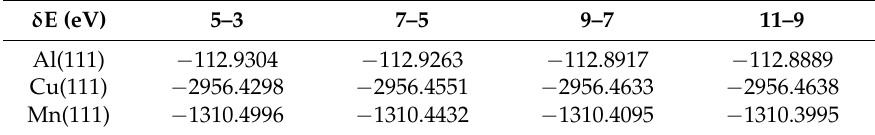
Table 1. The energy difference δ E of Al(111), Cu(111) and Mn(111) slab.